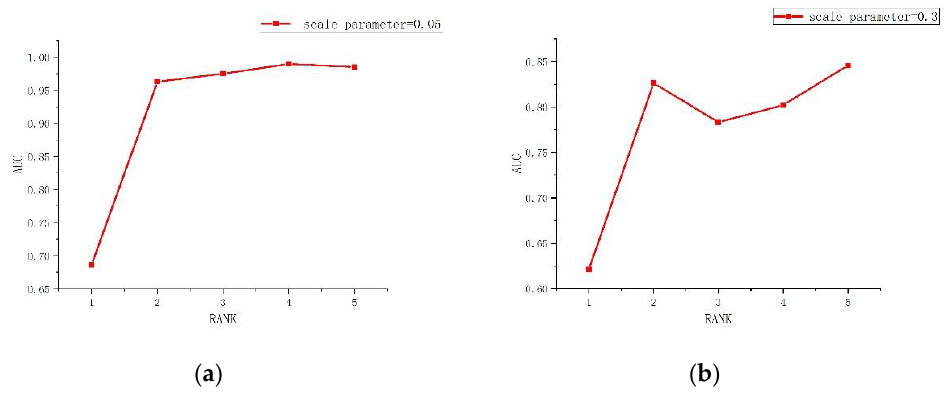
Figure 18. Analysis of the value of r . ( a ) The metal plates data set and ( b ) the car data set.